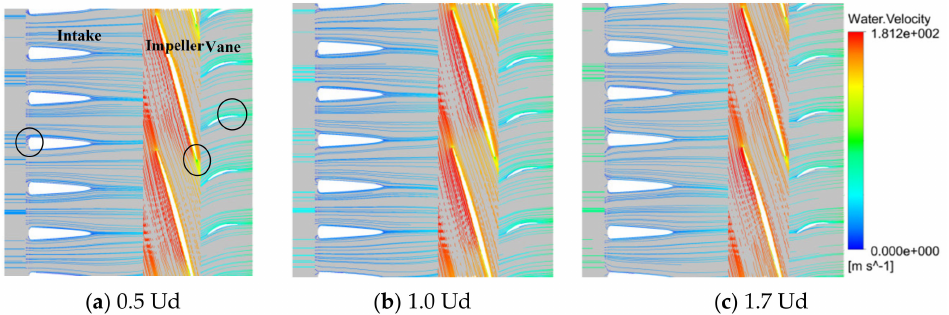
Figure 8. Distribution of the streamline in the pump